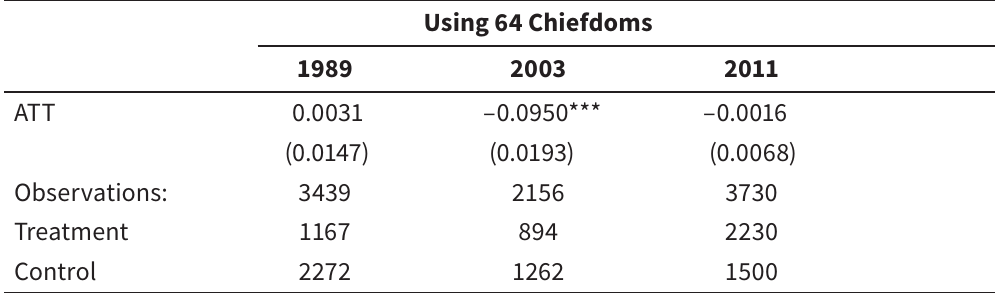
Table A2.12 The Impact of Conflict on the Gini Coefficient using Inverse Probability Weighting (With 64 Chiefdoms) based on Conflict